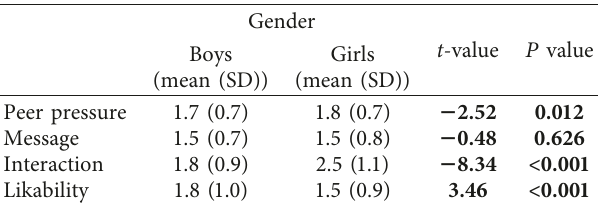
Table 2: Association of gender with perception of peer